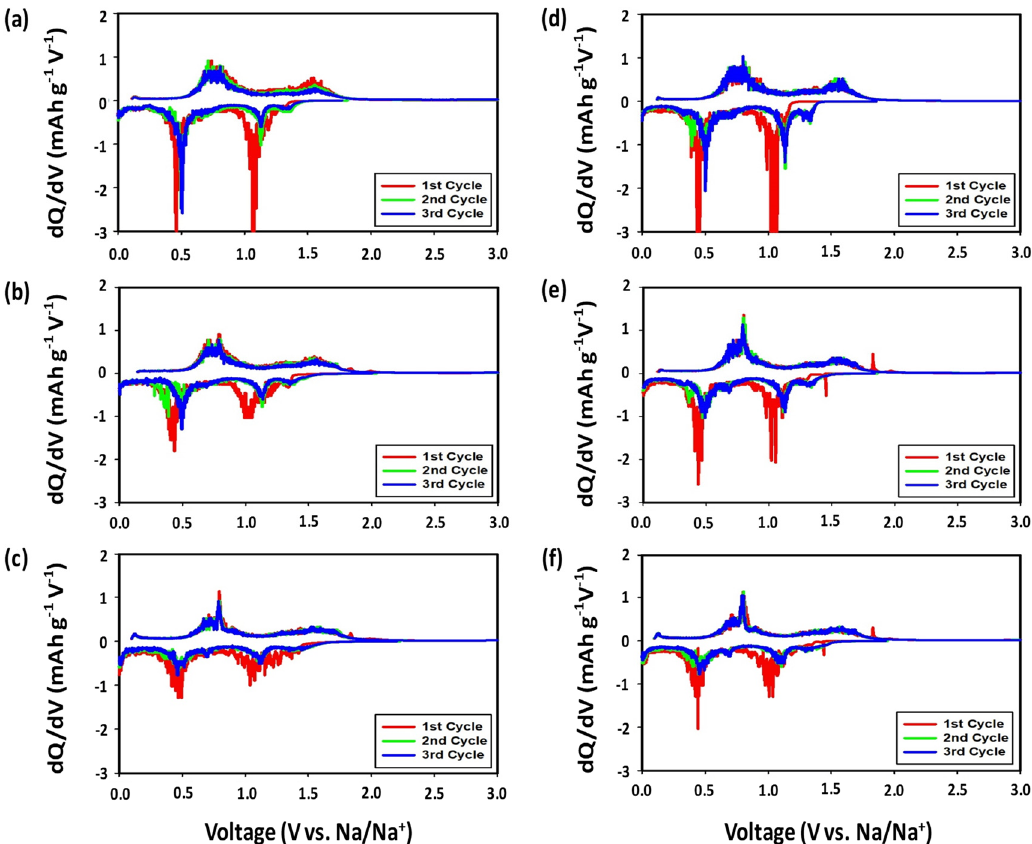
Figure 6. Differential capacity plots of the ( a , d ) SbTe-C20; ( b , e ) SbTe-C30; and ( c , f ) SbTe-C40 electrodes fabricated with (a–c) the PVDF binder with 5% FEC, and (d–f) the PAA binder with 5% FEC.